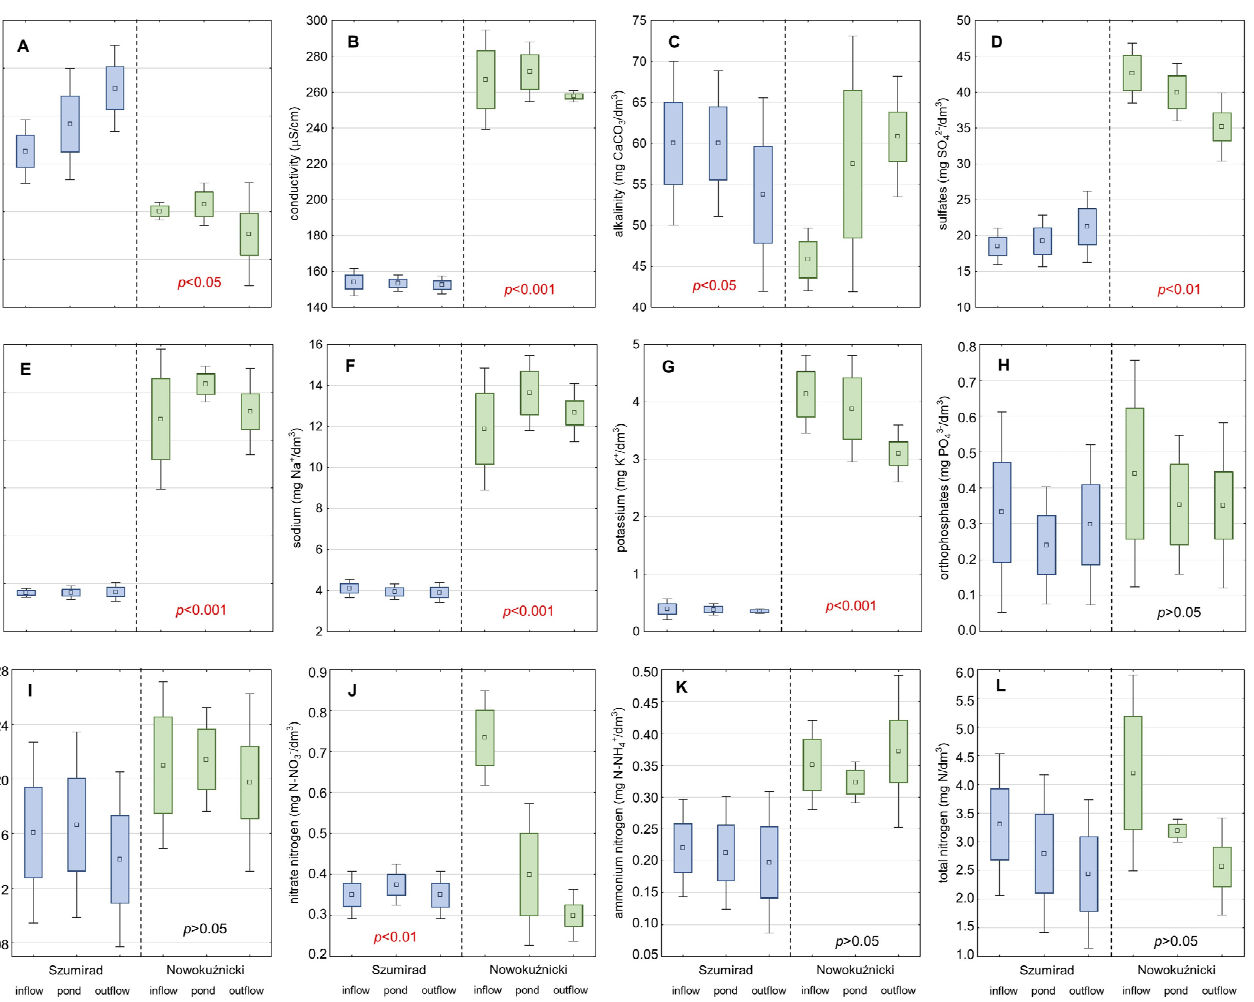
Figure 5. Comparison of the physico–chemical parameters of the water of the Szumirad reservoir and the Nowoku´znicki pond in 2014 (average of 5 measurements ± standard deviation): ( A )—pH, ( B )—conductivity, ( C )—alkalinity, ( D )—sulphates, ( E )—chlorides, ( F )—sodium, ( G )—potassium, ( H )—orthophosphates, ( I )—total phosphorus, ( J )—nitrate nitrogen, ( K )—ammonium nitrogen, ( L )—total nitrogen.